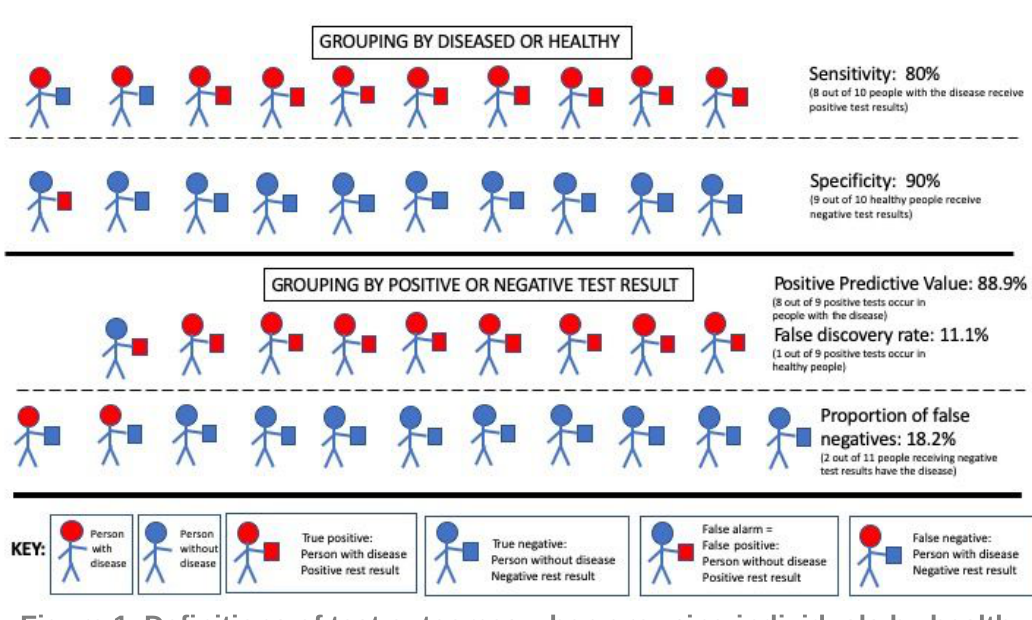
Figure 1. Definitions of test outcomes when grouping individuals by health status (sensitivity and specificity) or by test result (positive predictive value, false discovery rate, and proportion of false negatives). (See text for additional discussion). Note. Figure updated May 17, 2021, to correct typographic